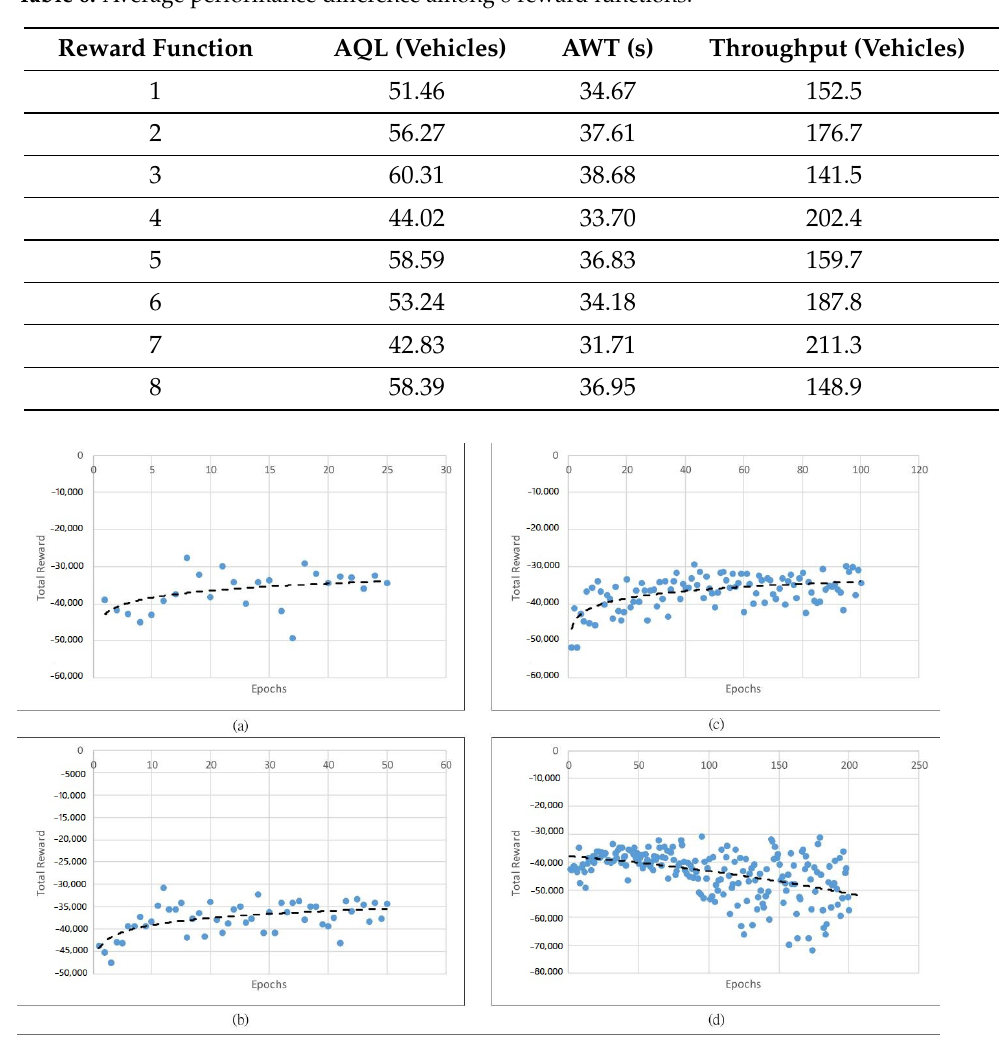
Table 6. Average performance difference among 8 reward functions.